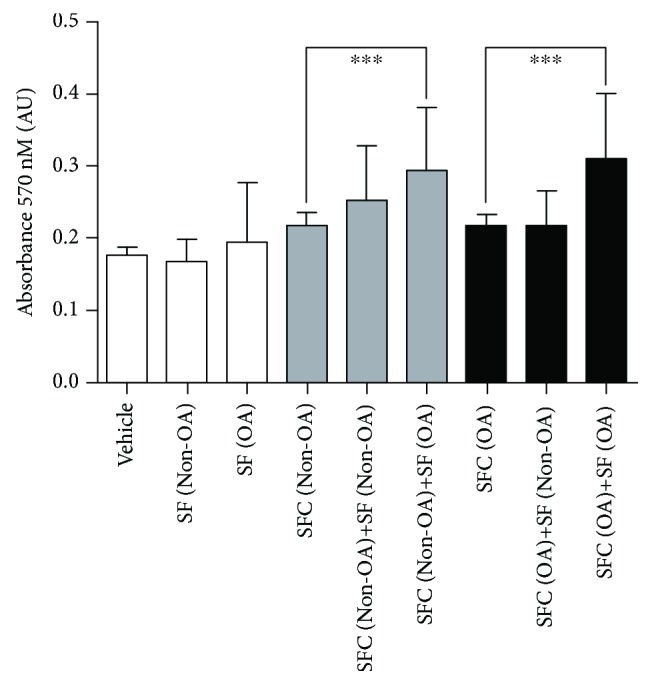
Mitochondrial activity of non-OA and OA SFC exposed to medium containing non-OA and OA SF. Medium containing non-OA and OA synovial fluid increases OA SFC (OA SFC 0.21 ± 0.002 vs. OA SFC+SF OA 0.30 ± 0.007; p < 0.0001, n = 7) and non-OA SFC activity (non-OA SFC 0.222 ± 0.003 vs. non-OA SFC+SF OA 0.30 ± 0.01; p = 0.0017, n = 7). OA: osteoarthritis.